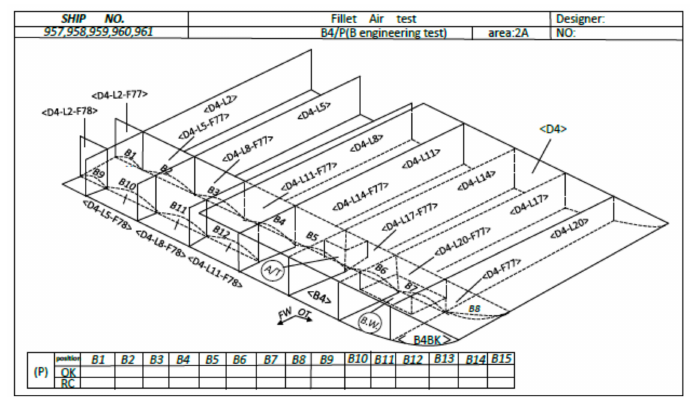
Figure 12. B engineering pressure test.